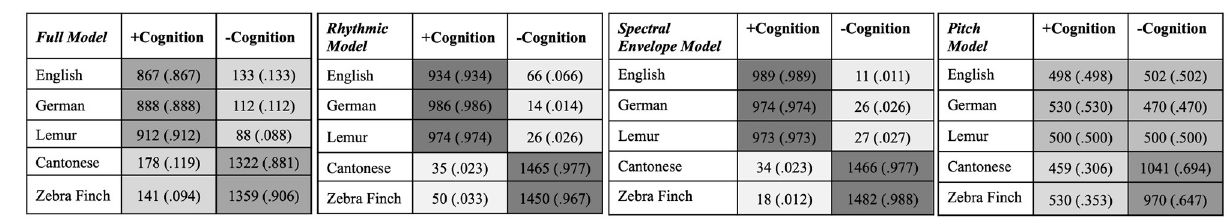
vocalizations that support cognition to perform